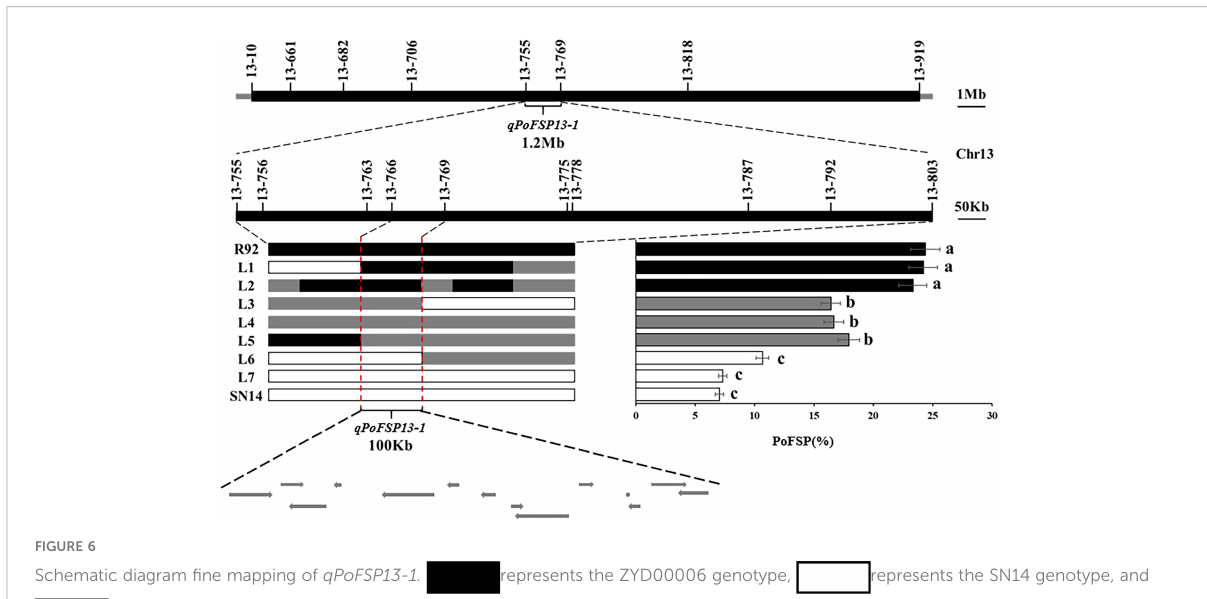
FIGURE 6 Schematic diagram fi ne mapping of qPoFSP13-1. represents the ZYD00006 genotype, represents the SN14 genotype, and represents the heterozygous genotype. R92, L1 and L2 were the same genotypes as ZYD00006; L3, L4 and L5 were heterozygous genotypes of ZYD00006, and L6 and L7 were the same genotypes as SN14. Different letters indicate the signi fi cant differences, while the same letters indicate the non-signi fi cant